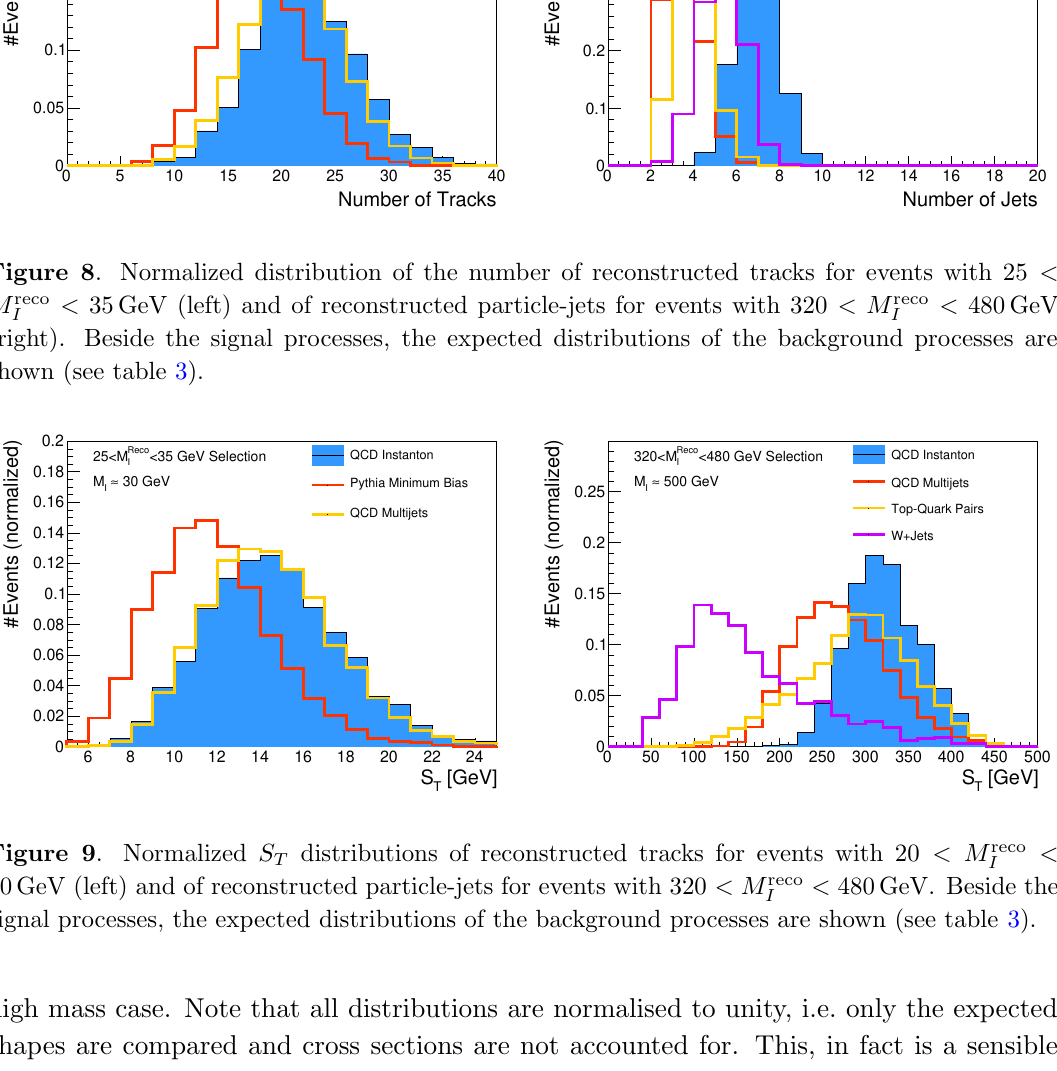
< I < 480 GeV. Beside the I